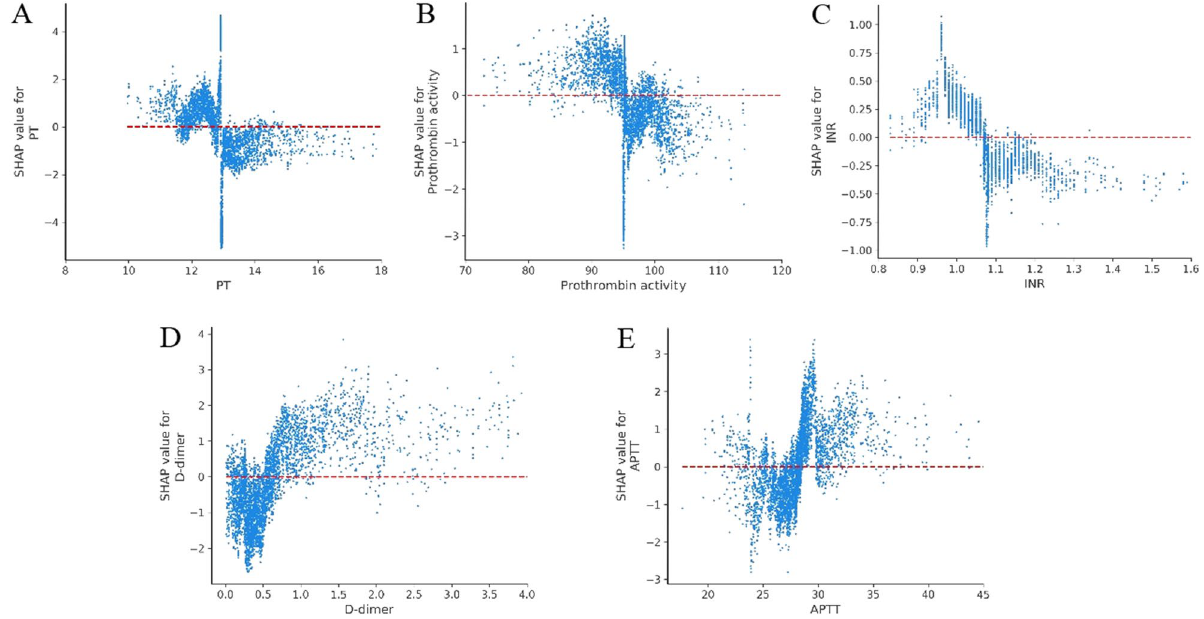
Figure 6. Partial SHAP dependence plots for blood coagulation. ( A ) PT. ( B ) PTA. ( C ) INR. ( D ) D-dimer. ( E ) APTT. PT: prothrombin time; PTA: prothrombin activity; INR: International normalized ratio; APTT: Activated partial thromboplastin time.